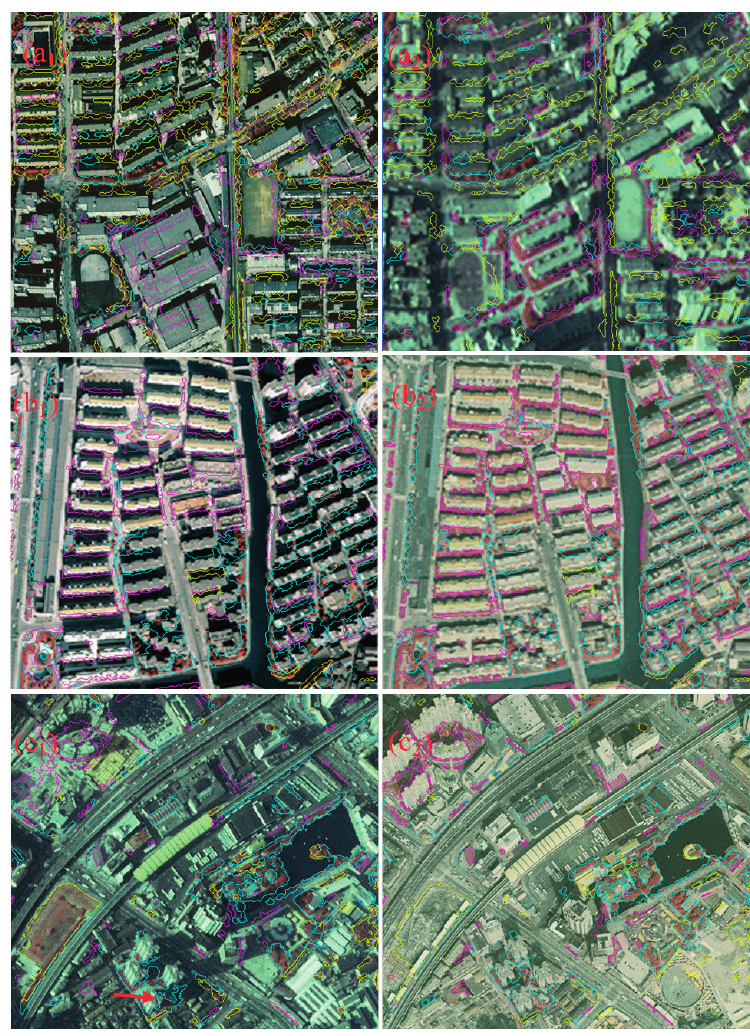
Figure 9. Three additional examples for the accuracy assessment of detecting vegetation changes. The years of the image pairs are: ( a ) 1993/2003; ( b ) 2000/2005; ( c ) 2003/2006 and all of the left ones take the image of date 1 as the background and the other the image of date 2.